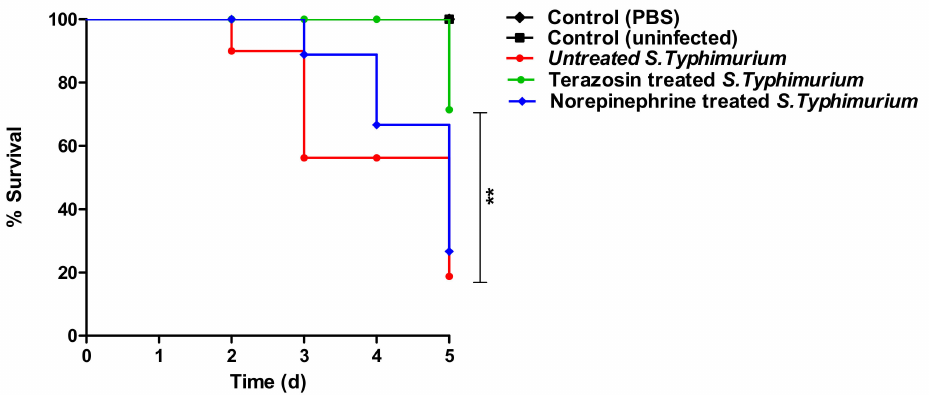
Figure 5. Terazosin protected mice against S. Typhimurium pathogenesis. Mouse groups ( n = 10) were injected either with 100 µ L (2 × 10 6 CFU/mL) of S. Typhimurium treated with norepinephrine (50 µ g/mL) or with terazosin at the sub-MIC or untreated S. Typhimurium, in addition to the negative control groups of the uninfected mouse group and the mouse group injected with sterile PBS. In mouse groups injected with untreated S. Typhimurium or norepinephrine-treated S. Typhimurium, only 4 mice survived. All mice survived in the negative control groups. However, terazosin protected 9 mice from S. Typhimurium. A Log-rank test for trend p = 0.0015 (** = p < 0.001).